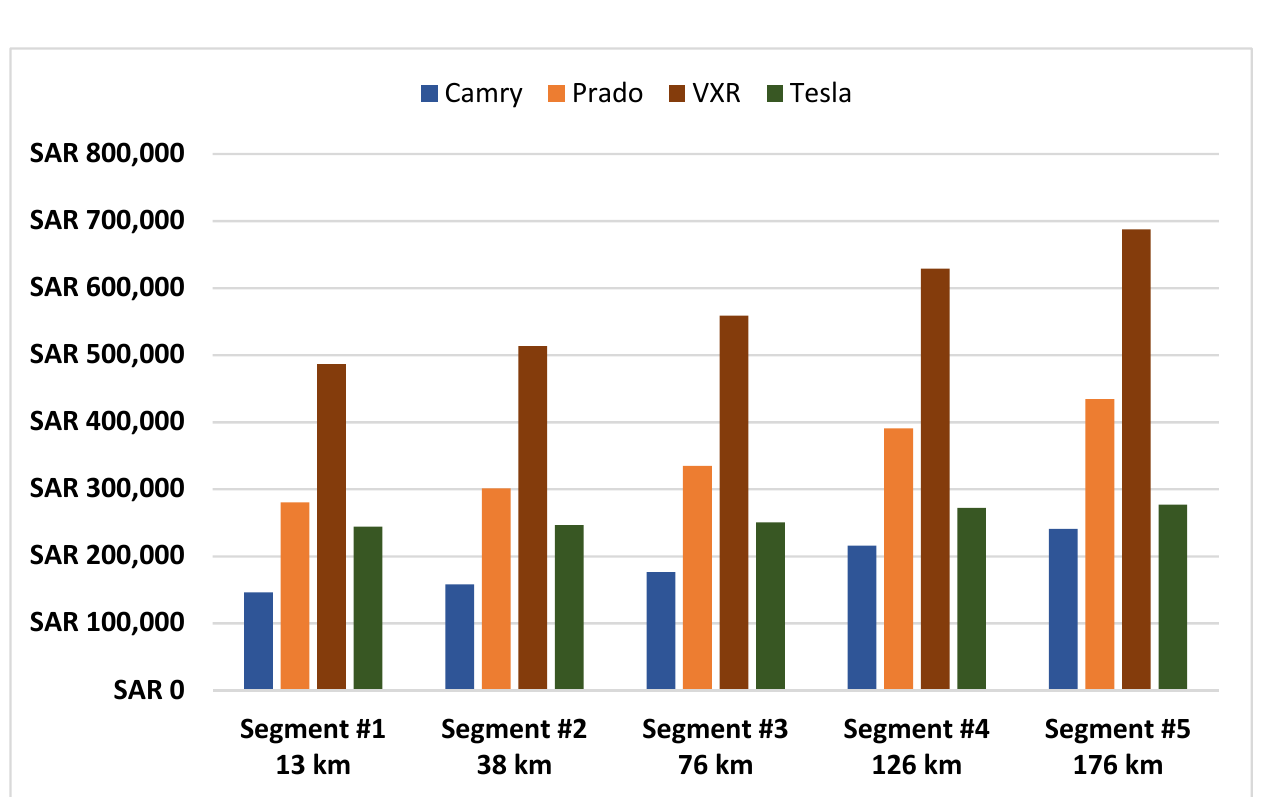
Figure 8. Thematic framework.